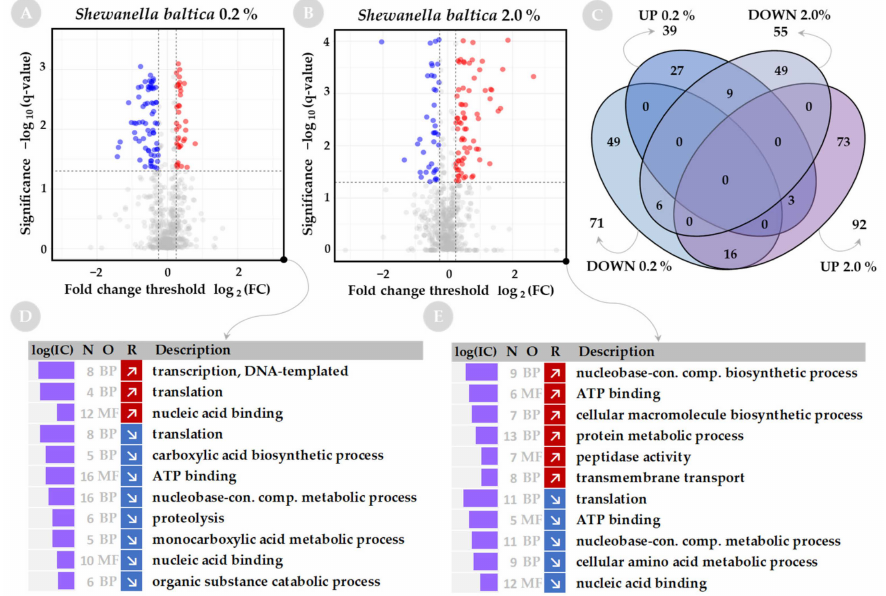
Figure 2. Global proteome changes in S. baltica in response to low (0.2%) and high (2.0%) salinity stress. Volcano plots presenting significantly up- and down-regulated proteins upon ( A ) low and ( B ) high salinity. Protein abundance, presented as log 2 -transformed fold change (FC) calculated versus protein abundance at optimal salinity, is plotted against the statistical significance presented as − log 10 -transformed q -value. Vertical and horizontal dashed lines indicate fold change thresholds set at |log 2 (FC)| ≥ 0.25 and − log 10 ( q -value) of < 1.3, respectively. Proteins with significantly increased and decreased levels are shown as red and blue dots, respectively. ( C ) Venn diagram showing numbers of significantly up- and down-regulated proteins at respective salinities; the total number of proteins with changed abundance is indicated outside each set. Annotation analysis of proteins with changed abundance upon ( D ) low and ( E ) high salinity. Schemes include the following columns: log-transformed information content (IC) score; the number of genes covered within the category (N); type of GO ontology (O)—biological process (BP) and molecular function (MF); type of regulation (R) with upwards pointing arrow on red background denoting upregulation, while downwards pointing arrow on blue background denotes downregulation of protein level; description denotes the name of GO terms retained in the analysis. The abbreviation nucleobase-con. comp. stands for the nucleobase-containing